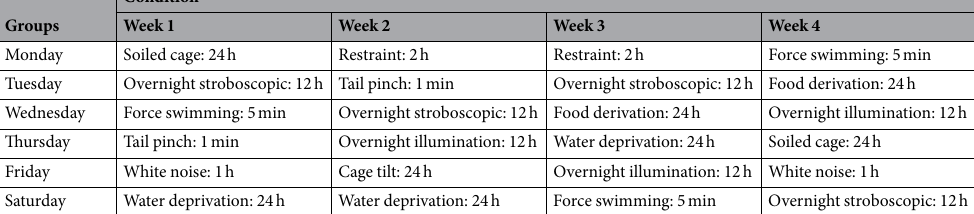
Table 1. Chronic unpredictable stress